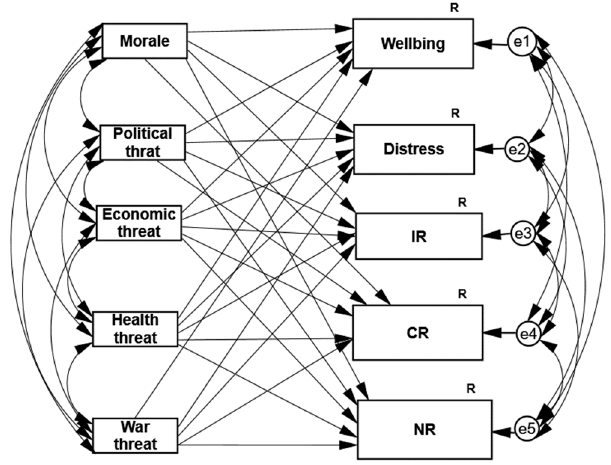
Figure 1. General model of the two path analyses—four types of threats and morale predicting distress; well-being; and individual, community, and national resilience during COVID-19 and Gaza armed conflict. R = square multiple correlations (explained variability in percentage). The letters and numbers represent residual error with ID number.